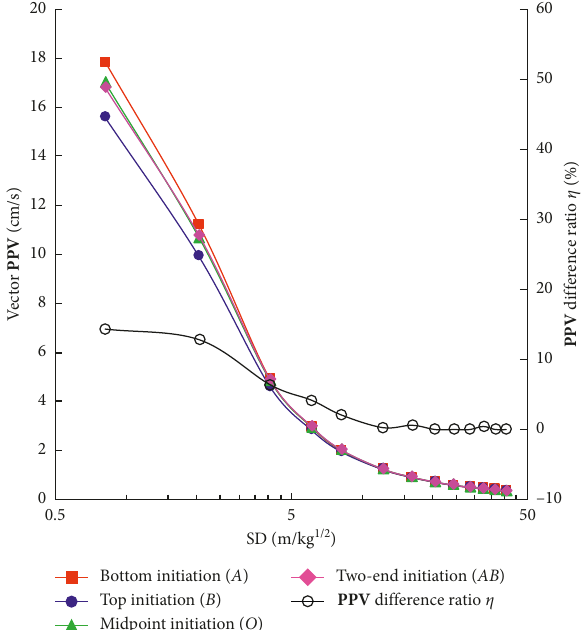
Figure 14: Illustration of the PPV difference ratio η observed along the radial direction of the cylindrical